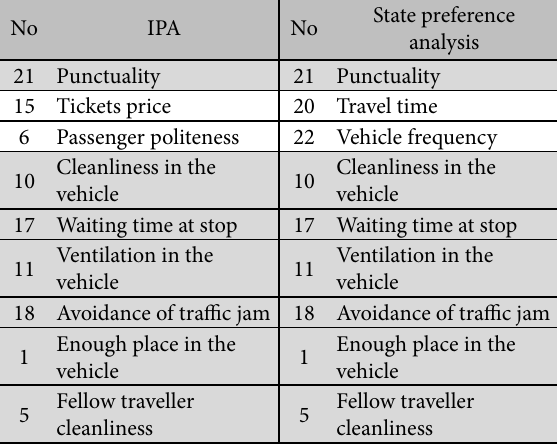
Table 4. Comparison of results obtained by IPA and by state preference